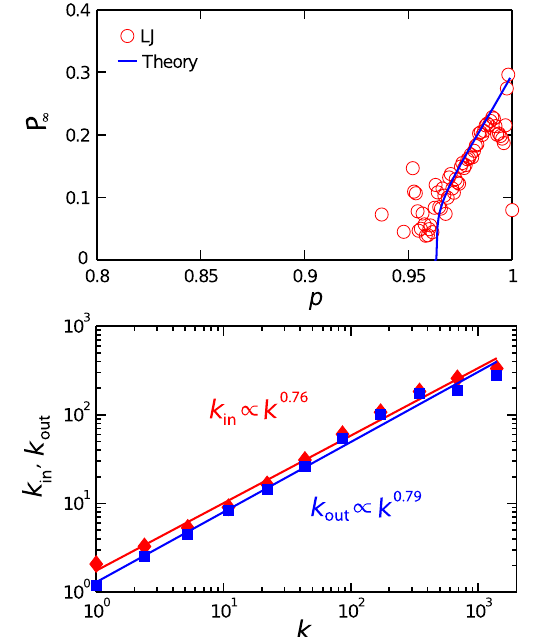
FIG. 5. Disintegration of communities of bloggers on Live- Journal. (a) Percolation plot in the plane ð p; P ∞ Þ of the declining communities. The communities follow a generic curve in the plane ð p; P ∞ Þ quantifying the rapid disintegration and cascading effects. We find a very good agreement with the empirical data that suggests that LJ communities disintegrate following a first- order transition. [See also Fig. 4(b) for the position of LJ in the phase diagram.] (b) Similarly to the results on the APS com- munities, we find positive local correlations of out- and in- influence degrees and connectivity degrees with exponents α ¼ 0 . 79 (cid:1) 0 . 03 and β ¼ 0 . 76 (cid:1) 0 . 03 ,